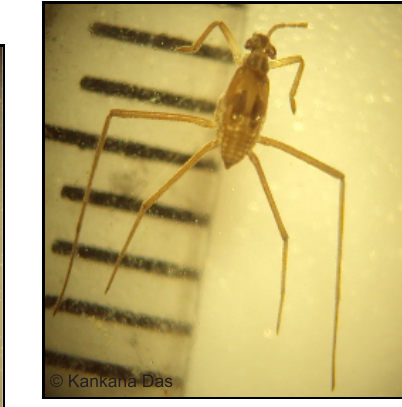
Image 9. Tenagogerris sp.